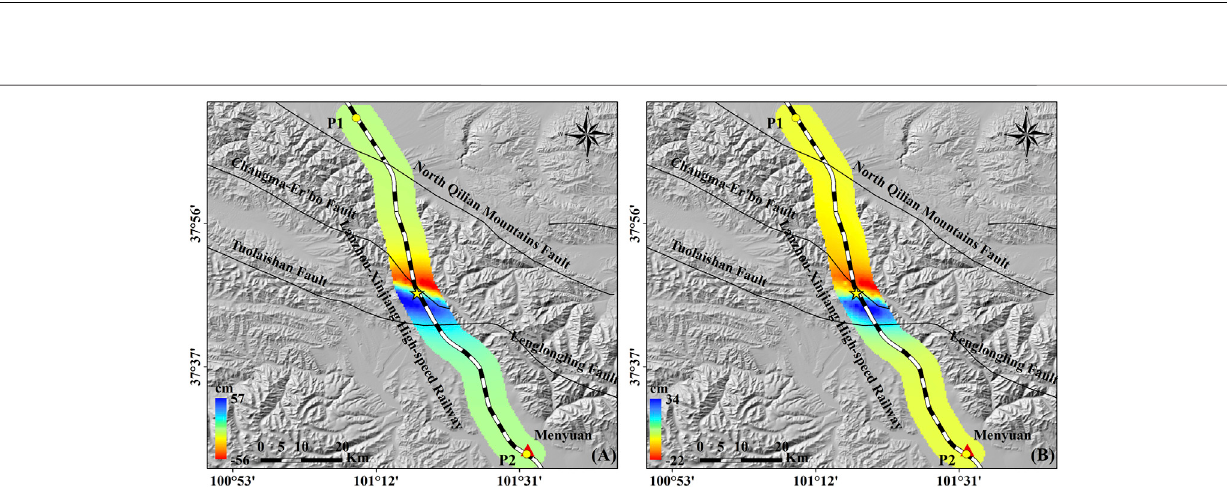
Frontiers in Environmental Science |